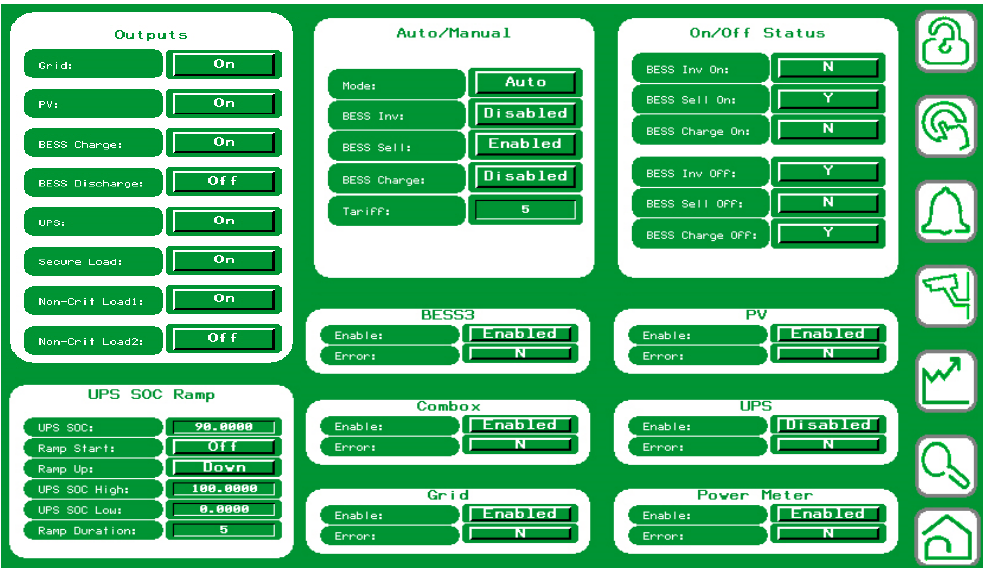
Figure 23. EMS control screen snapshot from HMI.